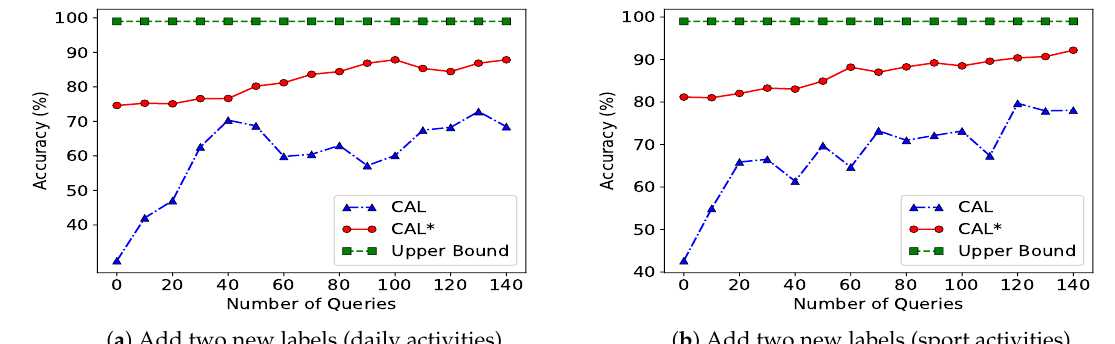
Figure 6. Performance of the collaborative active learning algorithm under a user need change (adding new labels) scenario. Subfigure ( a ) shows results for the daily activities dataset, and subfigure ( b ) shows results for the sport activities